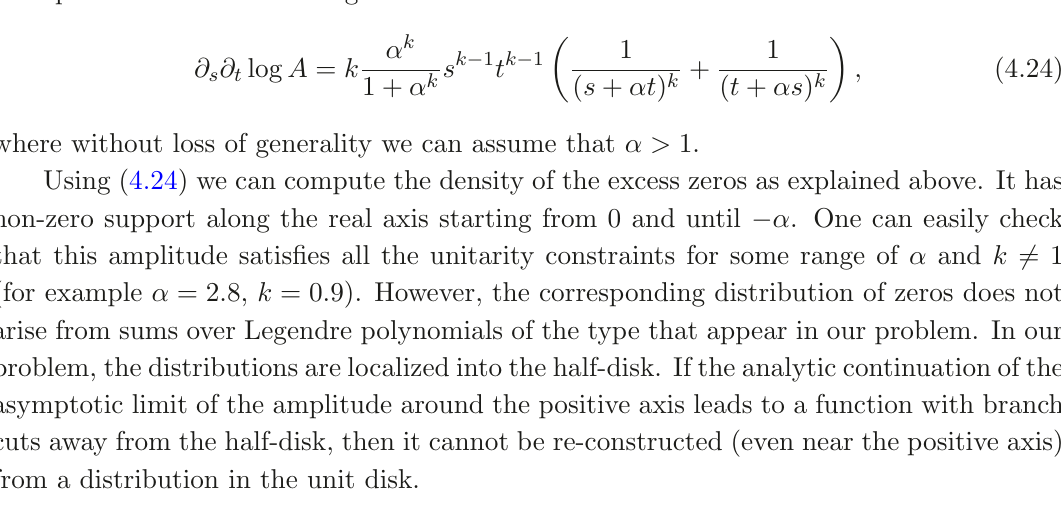
Figure 5 . Distribution of zeros for (4.23) for k = 3 random noise which is 10% of